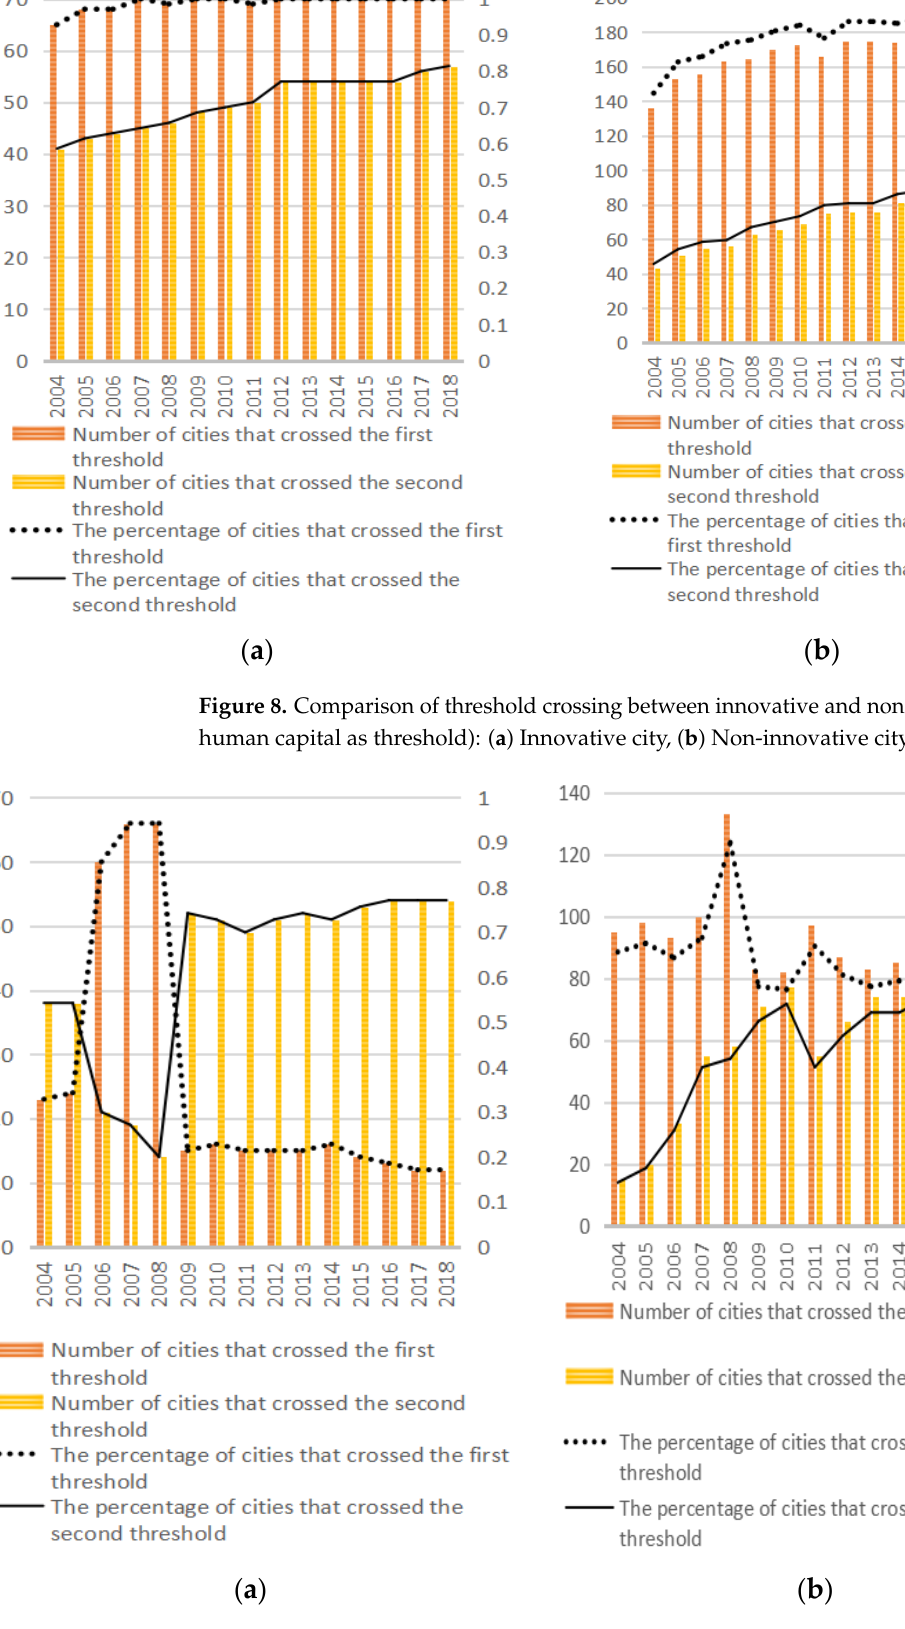
Figure 9. Comparison of threshold crossing between innovative and non-innovative cities (taking the industry size as threshold): ( a ) Innovative city, ( b ) Non-innovative city.